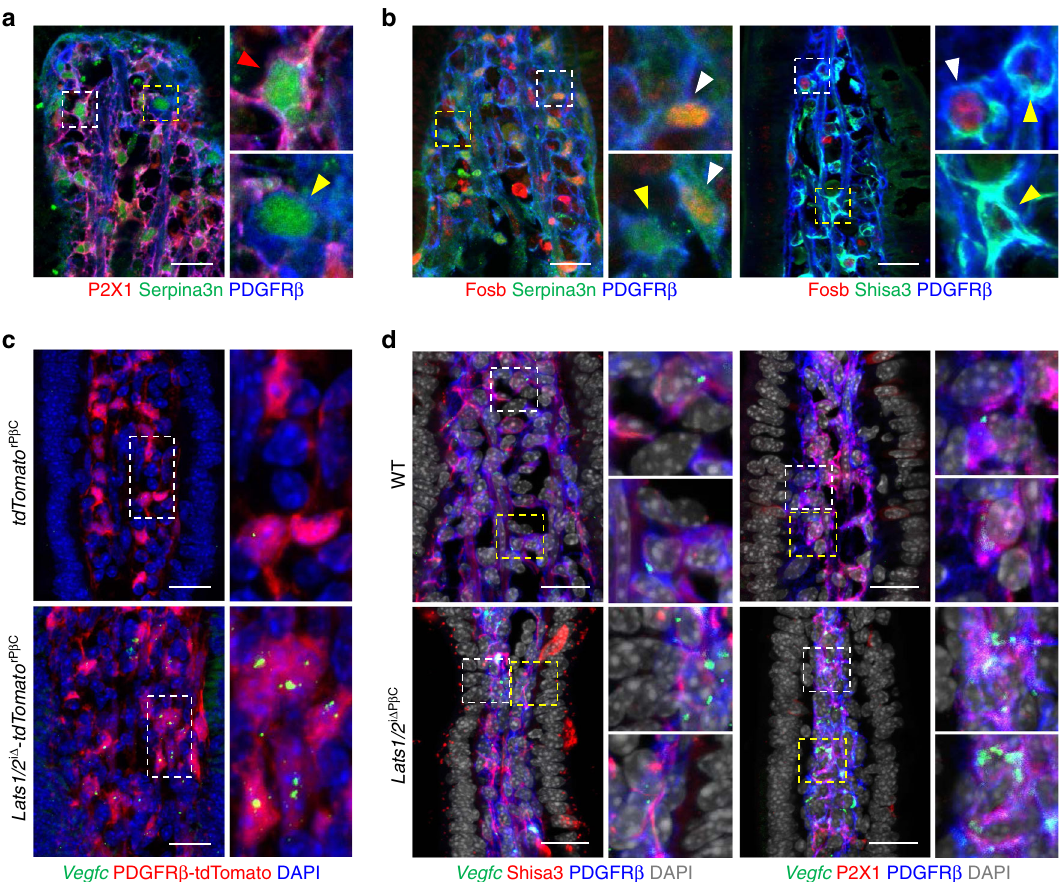
Fig. 8 vFB1-3 are distinct cell types secreting VEGF-C. a Representative images of vFB3 (P2X1 + Serpina3n + PDGFR β + ) and vFB1-2 (P2X1 - Serpina3n + PDGFR β + ) in WT mouse. Similar fi ndings were observed in n = 4 mice from two independent experiments. White and yellow dotted boxes are magni fi ed in the upper right and lower right panels, respectively. Red and yellow arrowheads indicate vFB3 and vFB1-2, respectively. Scale bar, 20 μ m. b Representative images of vFB1 (Serpina3n + Fosb + Shisa3 + PDGFR β + ) and vFB2 (Serpina3n + Fosb - Shisa3 + PDGFR β + ) in WT mouse. Similar fi ndings were observed in n = 4 mice from two independent experiments. White and yellow dotted boxes are magni fi ed in the upper right and lower right panels, respectively, for each image. White and yellow arrowheads indicate vFB1 and vFB2, respectively. Scale bars, 20 μ m. c Representative images of Vegfc single-molecule fl uorescence in situ hybridization (smFISH) in intestinal villi of tdTomato rP β C and Lats1/2 i Δ - tdTomato rP β C mice. Similar fi ndings were observed in n = 4 mice/group from two independent experiments. White dotted boxes are magni fi ed in the right panel. Scale bars, 20 μ m. d Representative images of Vegfc smFISH in vFB1-3 of WT and Lats1/2 i Δ - tdTomato rP β C mice. Similar fi ndings were observed in n = 4 mice/group from two independent experiments. White and yellow dotted boxes are magni fi ed in the upper right and lower right panels, respectively, for each image. Scale bars, 20 μ